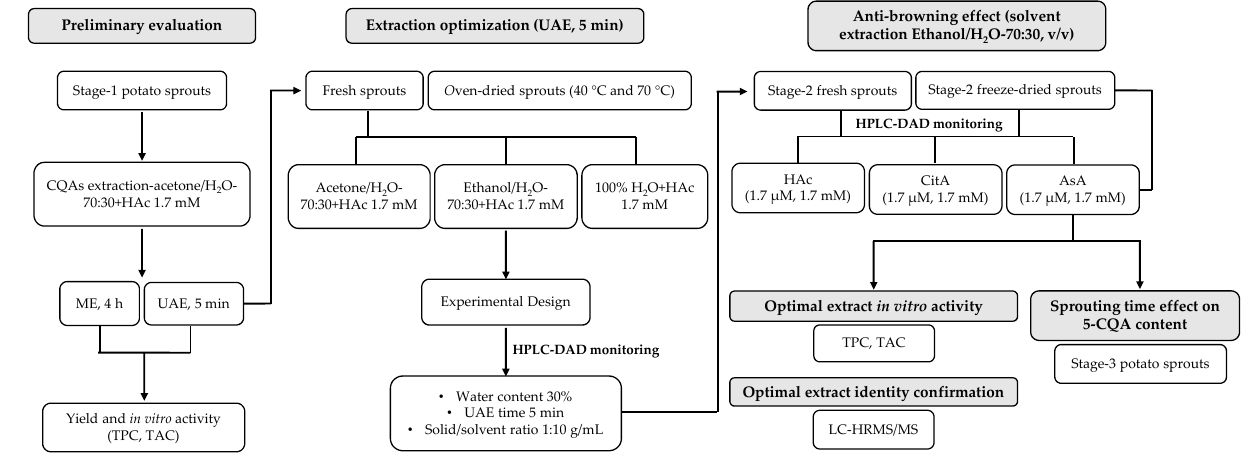
Figure 1. Overview of extraction optimization for 5-CQA recovery from potato